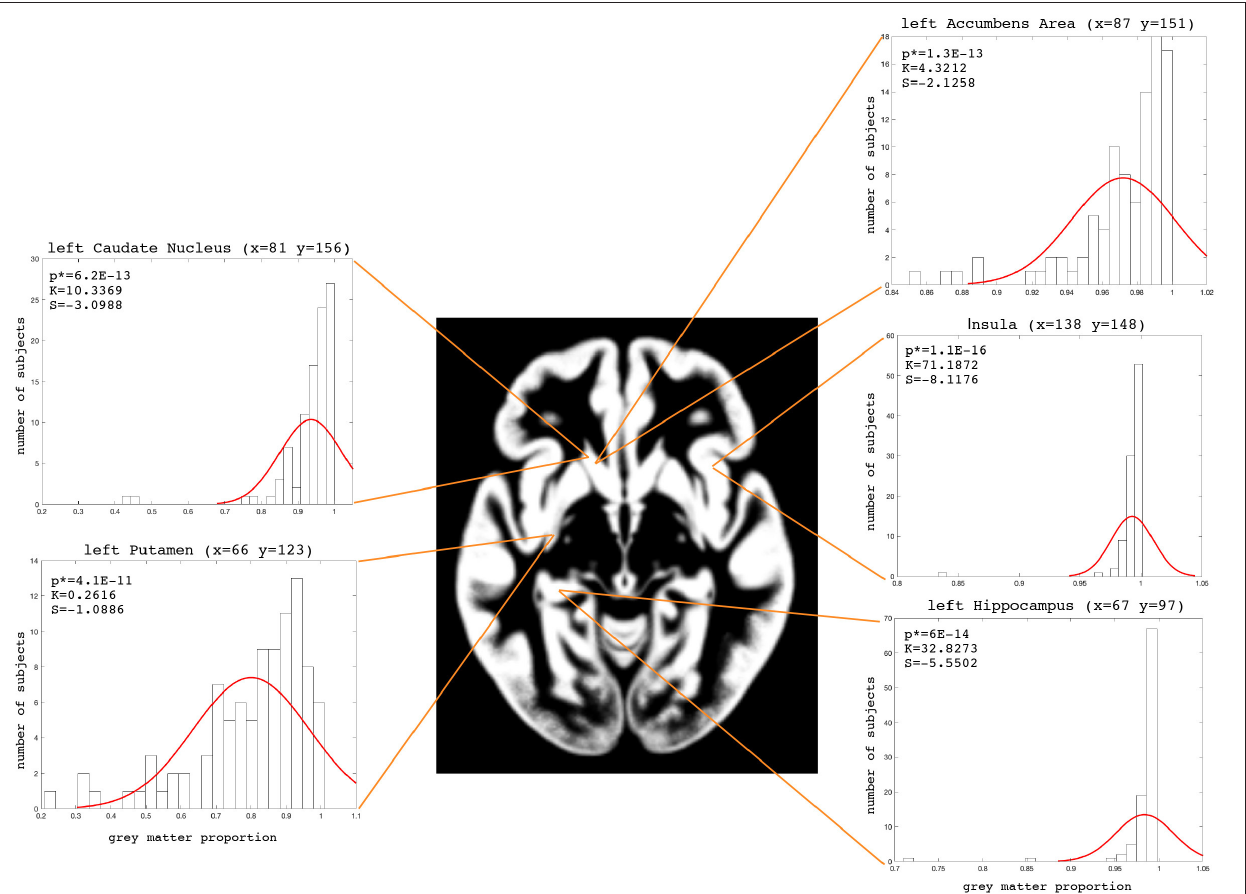
FIGURE 3 | Axial slice (z = 72) for the median gray matter map. The histograms with the skewness (S), kurtosis (K), and Shapiro-Wilk test p -values (p*) for the left Caudate Nucleus, left Putamen, left Accumbens Area, left Hippocampus and Insula.